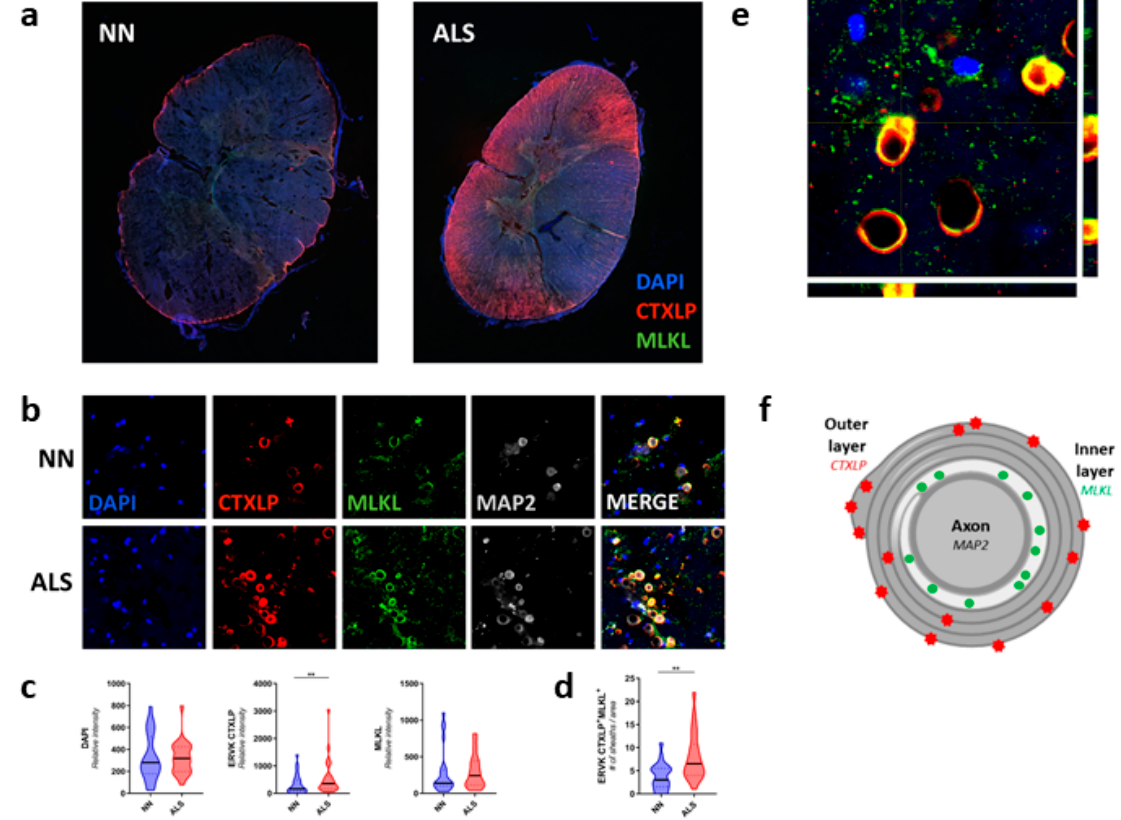
Figure 5. ERVK CTXLP is enhanced in the spinal cord of patients with ALS and associated with axonal sheaths. ( a ) ERVK CTXLP levels are enhanced in autopsy spinal cord tissues of patients with ALS, as measured by confocal microscopy. Representative 10 × mosaic confocal micrographs of ERVK CTXLP (red), MLKL (necroptosis marker, green), and DAPI (nuclear marker, blue) in the cervical spinal cord of a neuro-normal (NN) control and a patient with ALS. Note the intense CTXLP staining in the lateral corticospinal tract, surrounding a lesioned area in ALS. ( b ) Representative 40 × confocal micrographs of ERVK CTXLP (red), MLKL (necroptosis marker, green), and neuronal MAP2 expression (grey) in the cervical spinal cord of a NN control ( n = 5) and a patient with ALS ( n = 5). DAPI stain depicts nuclei. ( c ) Violin plots of staining quantification of DAPI, CTXLP, and MLKL in NN and ALS cohorts for cervical spinal cord. ( d ) Violin plots of protein quantification of CTXLP + MLKL + sheaths in cervical spinal cord. Statistical test with unpaired two-tailed t -tests (** p < 0.01, black bars are medians). ( e ) Projected image of a 5 µ m tissue section depicting CTXLP + MLKL + sheaths in the cervical spinal cord of a patient with ALS. The oligodendrocyte cell body is indicated by an asterisk and myelin sheath by an arrow. CTXLP + rings ranged from 6–16 µ M in diameter, with clear di ff erences in the thickness of the sheaths surrounding axons. ( f ) Diagram of CTXLP + MLKL + sheaths surrounding neuronal axons in ALS. Image produced with BioRender and PowerPoint.